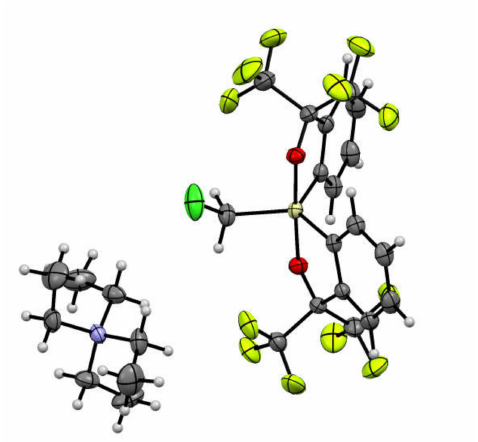
Figure 2. X-Ray structure of chloromethylsilicate 2 (CCDC number 2124348). Ellipsoids are shown with 50% of